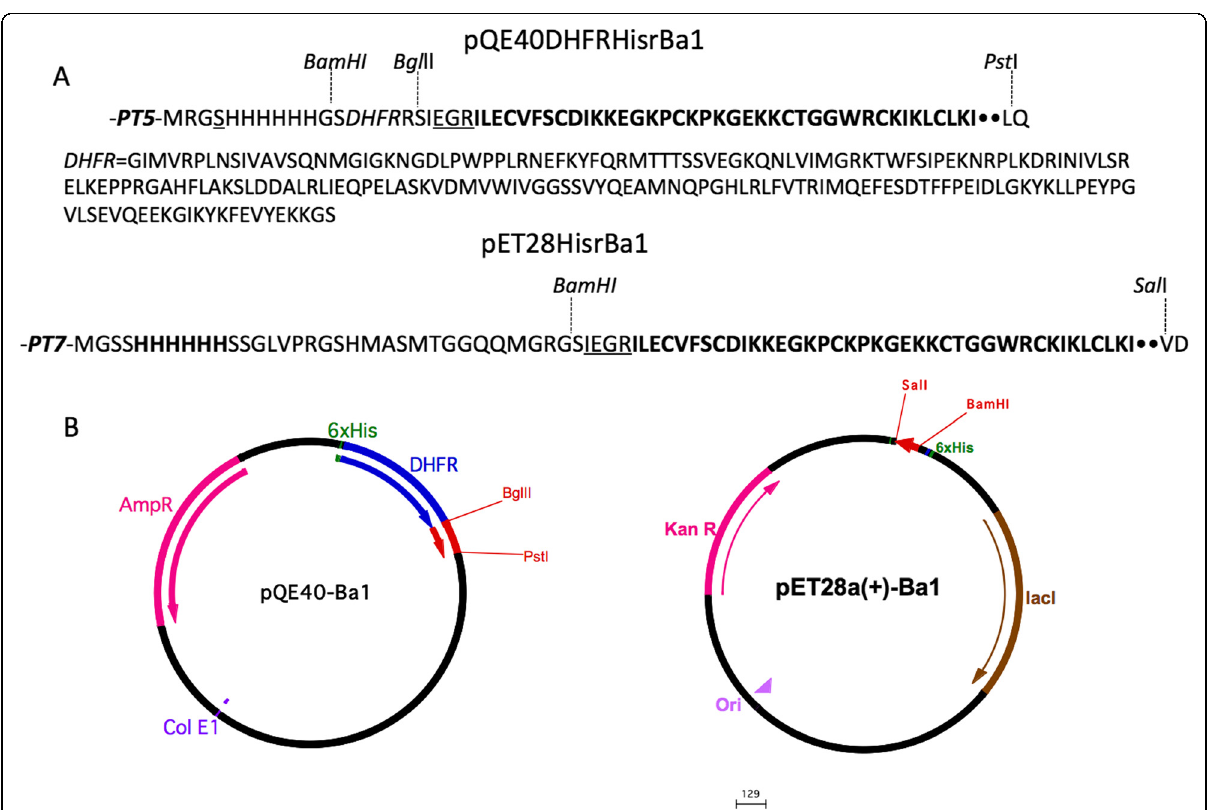
Fig. 1 Gene construction of the plasmids carrying either pQE40HisrDHFRBa1 or pET28HisrBa1. a The organization of the gene and amino acid sequences in pQE40HisrDHFRBa1 and pET28HisrBa1. b Schematic representation of the expression